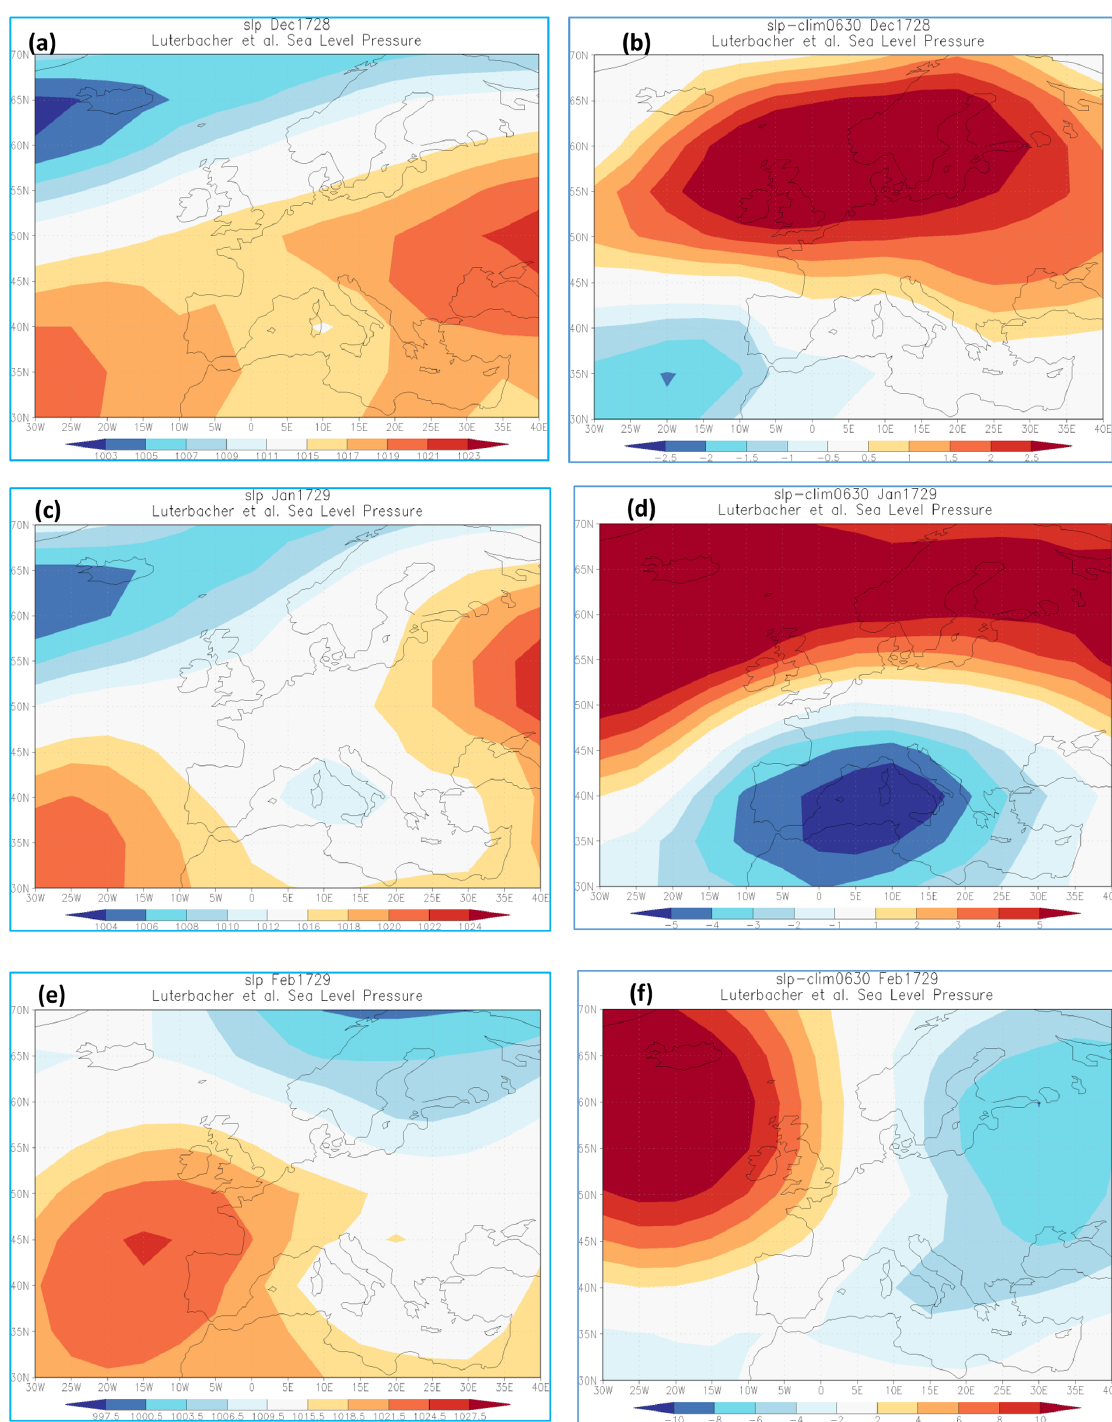
Figure 9. Reconstruction of the monthly SLP field in western Europe (a, c, e) and anomalies of the monthly SLP field with respect to the reference period 1906–1930 (b, d, f) for December (a, b) , January (c, d) , and February (e, f) 1729, according to Luterbacher et al.